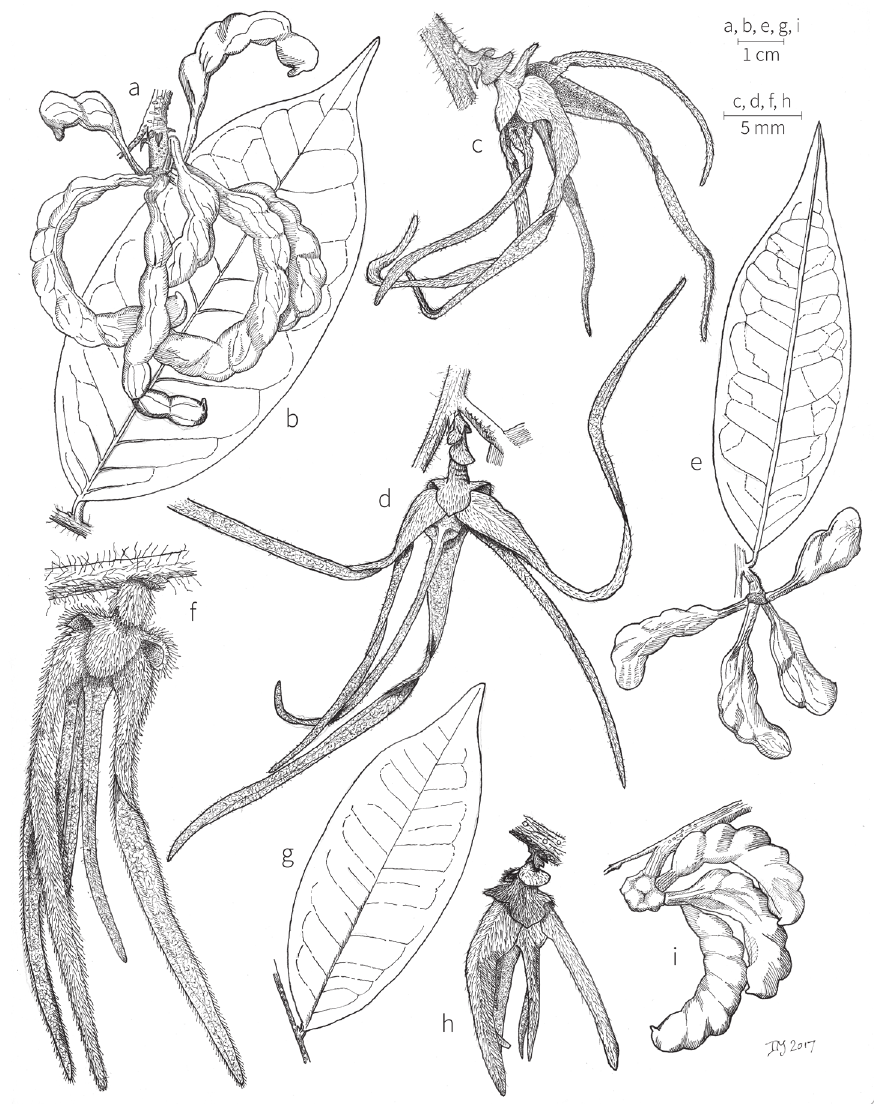
Figure 39. Xylopia thomsonii , X. monticola , X. talbotii , and X. dinklagei . A–C X. thomsonii A Fruit B Leaf C Flower D–E X. monticola D Flower E Leaf and fruit F X. talbotii , flower, side view G–I X. din- klagei G Leaf H Flower I Fruit. A from de Wilde & de Wilde-Duyfjes 2703 (K) B, C from Talbot & Talbot 3267 (BM) D from Chapman 3755 (K) E from Thomas et al. 7400 (MO) F from Thomas 3204 (MO) G, H from Dinklage 1840 (A) I from Baldwin 10805